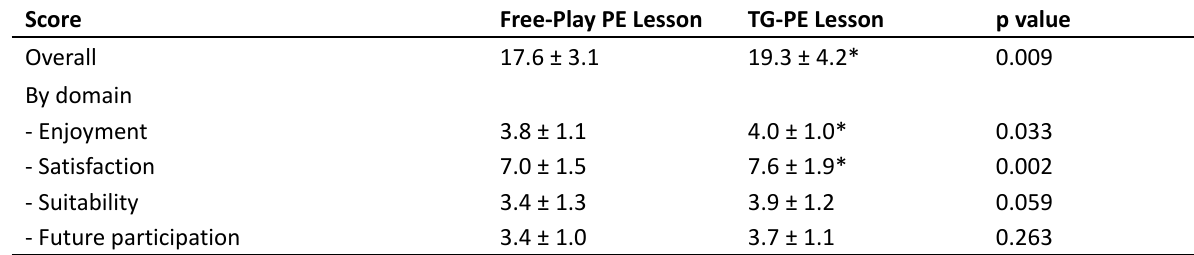
Table 4 . Comparison of Acceptance Score towards Free-Play PE lesson and TG-PE Lesson (Mean ± SD)